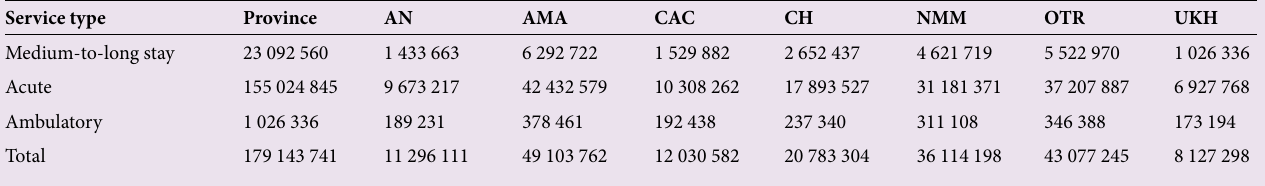
Table 10. Per annum cost in ZAR for nursing staff per service